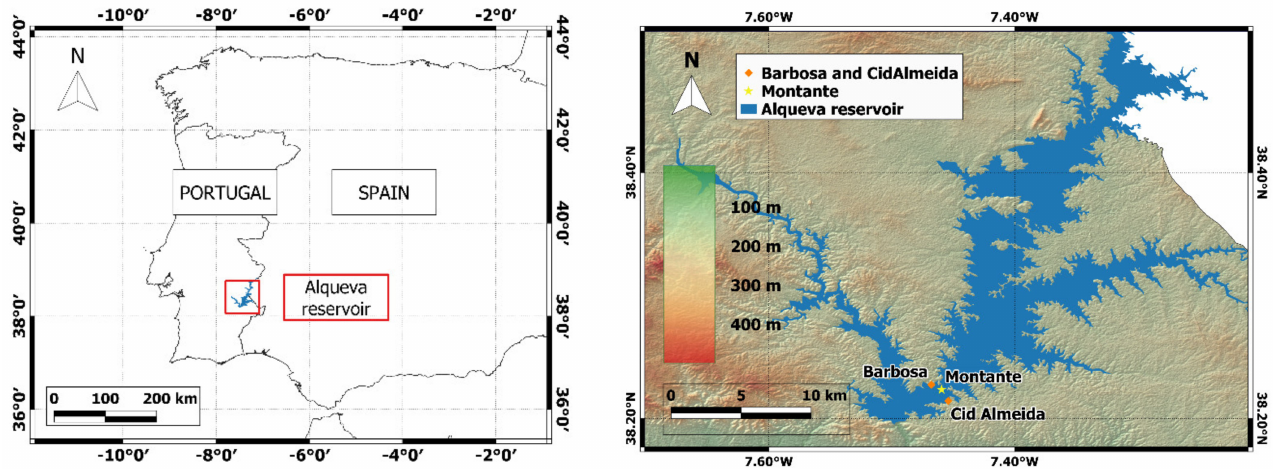
Figure 1. Localization of Alqueva reservoir ( left panel ) and location of meteorological stations used in this study ( right panel ). Source: